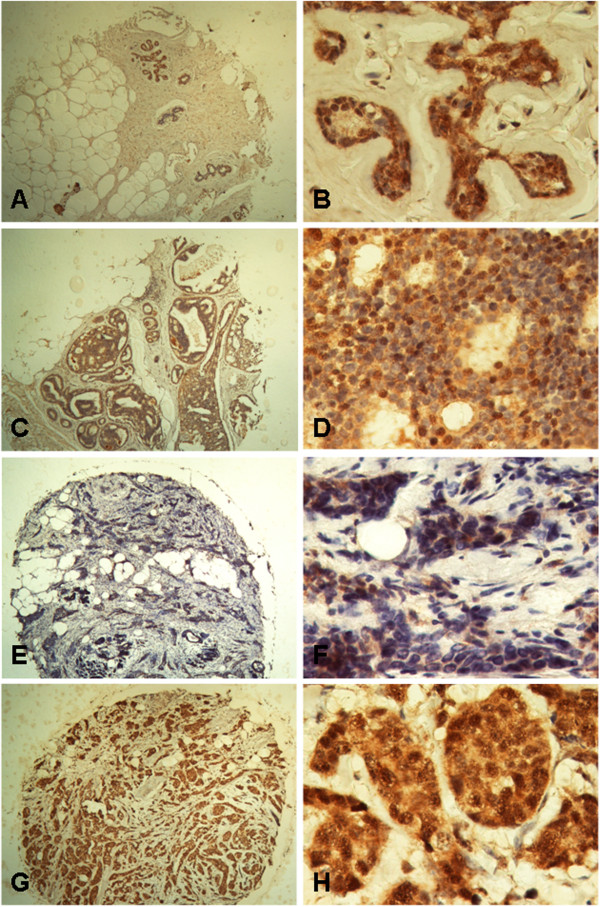
SERBP1 protein is not differentially expressed between normal and cancerous human breast tissue on TMA. SERBP1 protein was expressed heterogeneously in the nucleus as well as in the cytoplasm of normal and cancerous breast epithelial cells whereas no staining could be detected in stromal cells. Differences between the respective groups were statistically not significant. (A, B) Normal breast tissue showed moderate nuclear and cytoplasmic SERBP1 protein expression (IRS = 6) in the epithelial cells. (C, D) Ductal carcinoma in situ revealed a moderate nuclear and cytoplasmic SERBP1 staining (IRS = 6). (E, F) In invasive breast carcinoma (here: ductal type) SERBP1 expression was low (example shows nuclear and cytoplasmic staining with an IRS = 1). (G, H) Invasive breast carcinoma (here: ductal type) also displayed abundant nuclear (IRS = 8) and cytoplasmic SERBP1 protein expression (IRS = 12). Magnifications: A, C, E, G: 40x; B, D, F, H: 400x.